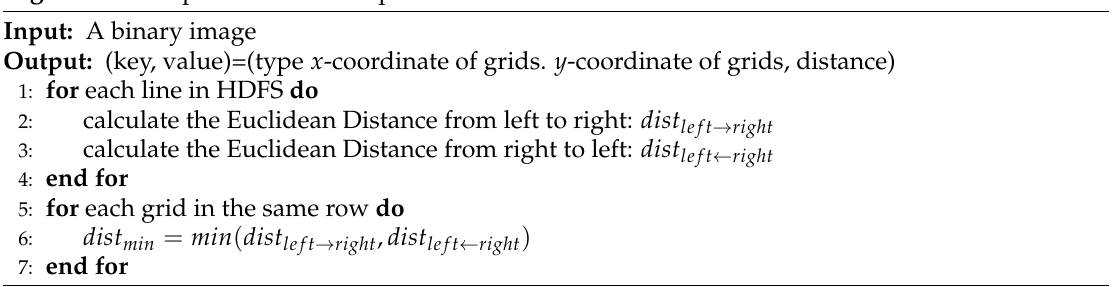
Algorithm 1 Map Function for Step 1 Process